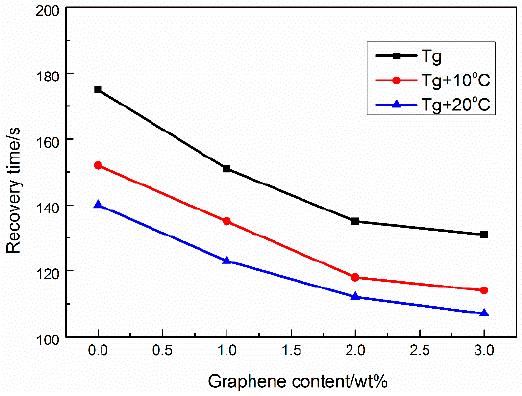
Figure 9. The effect of the temperature on the shape recovery time of the composites.